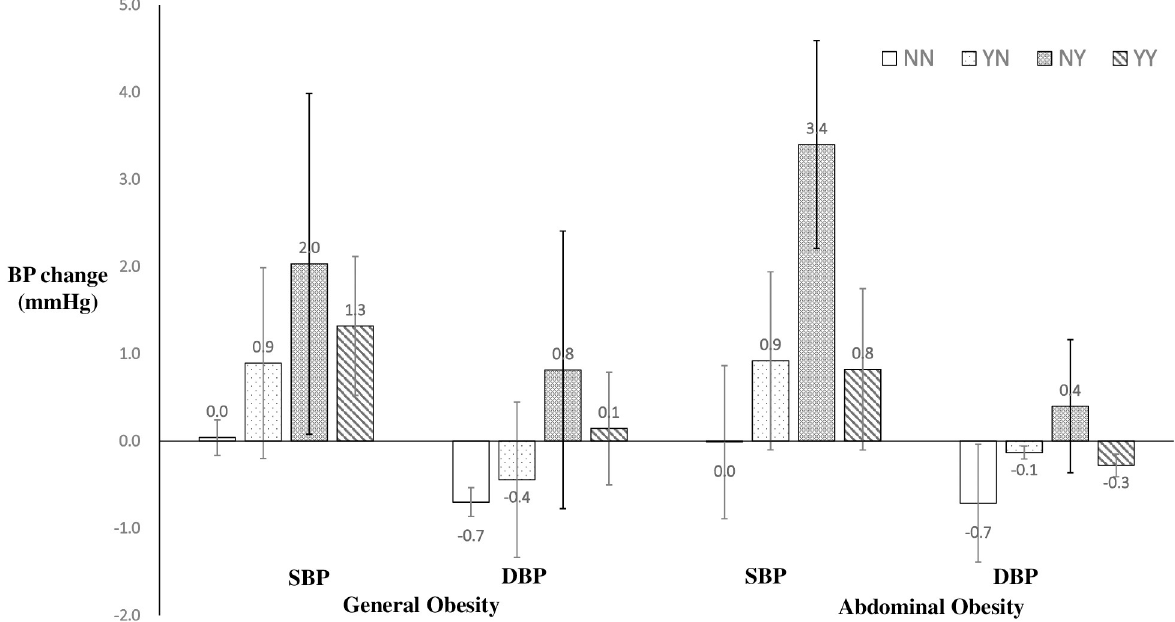
Fig 1. Adjusted means and 95% confidence interval of blood pressure change from baseline to the follow-up in different general or abdominal obesity status change groups. NN: non-obese at baseline and non-obese at follow-up; NY: non-obese at baseline and obese at follow-up; YN: obese at baseline and non-obese at follow-up; YY: obese at baseline and obese at follow-up. Means were adjusted for age, gender, area, BMI, fruit consumption, vegetable consumption, sugar-sweetened beverage intake and physical activities.